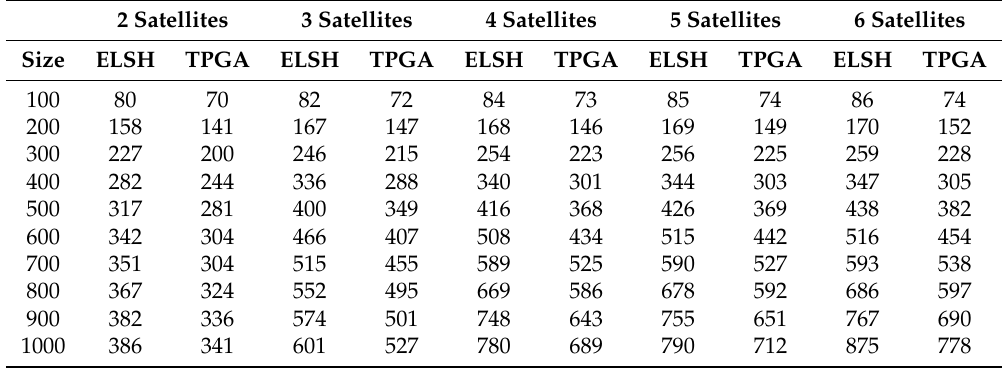
Table 3. Comparison with TPGA on the observed target number on area distribution